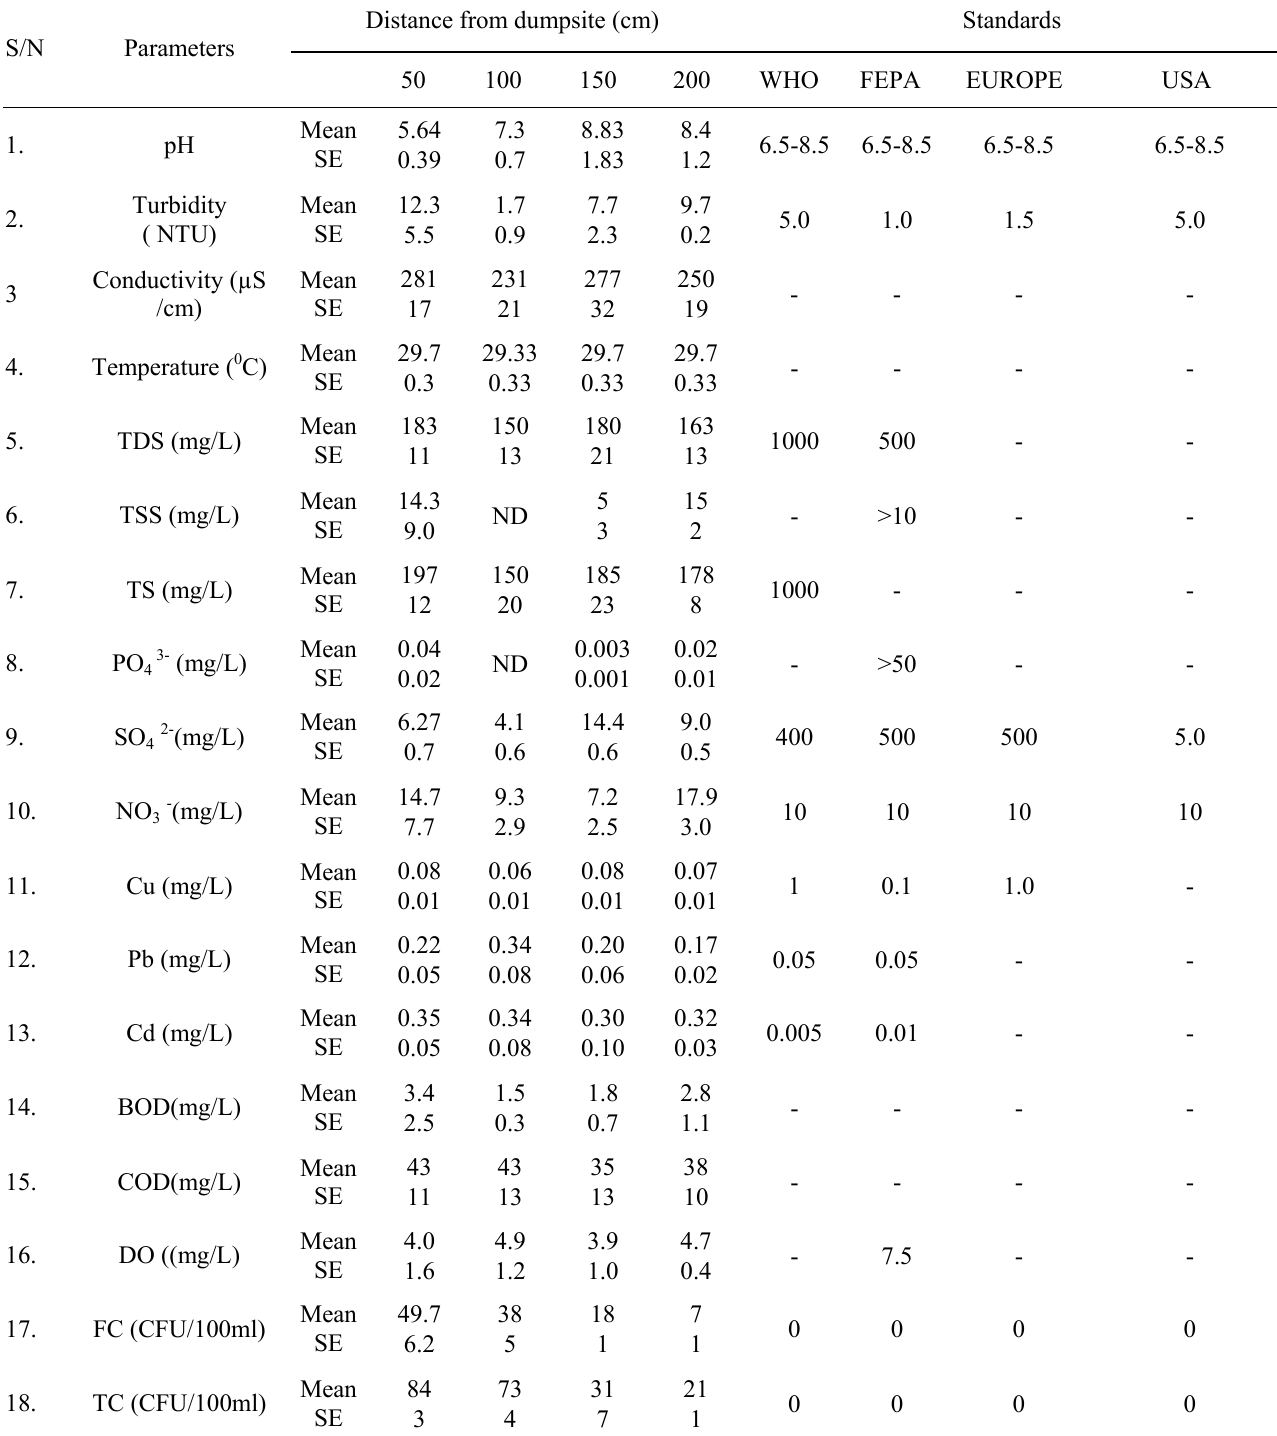
Table 3 : Mean values of the water quality parameters of wells located close to defecation site in the dry season Distance from dumpsite S/N Parameters